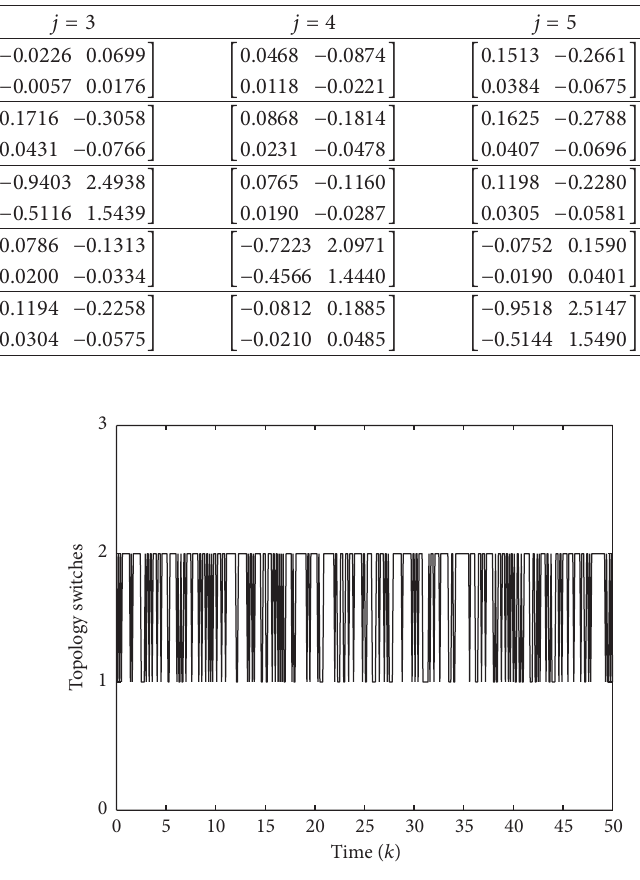
Figure 3: Topology